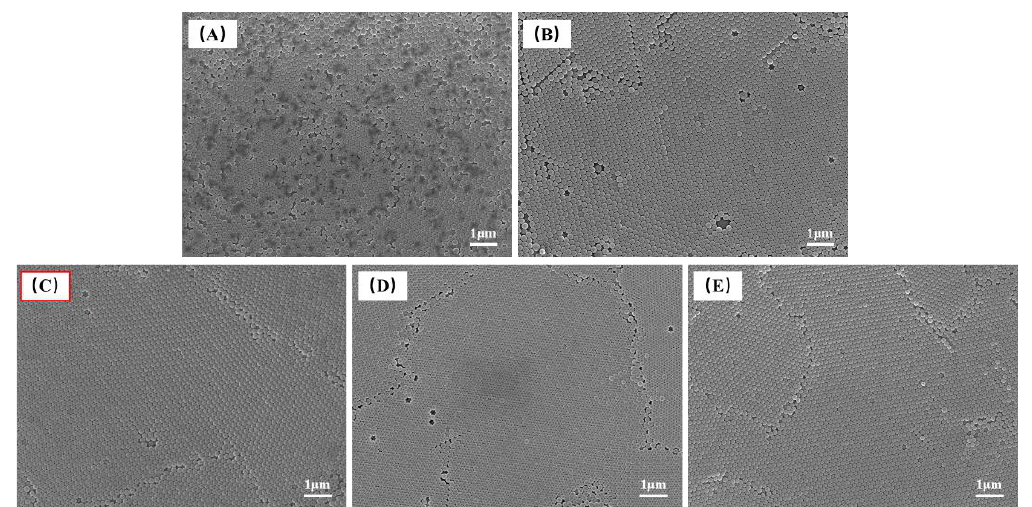
Figure 2. FE-SEM images of PSt colloidal microspheres synthesized with the following amount of SDBS added: ( A ) 125 mg; ( B ) 150 mg; ( C ) 175 mg; ( D ) 200 mg; ( E ) 225 mg. SDBS added: ( A ) 125 mg; ( B ) 150 mg; ( C ) 175 mg; ( D ) 200 mg; ( E ) 225